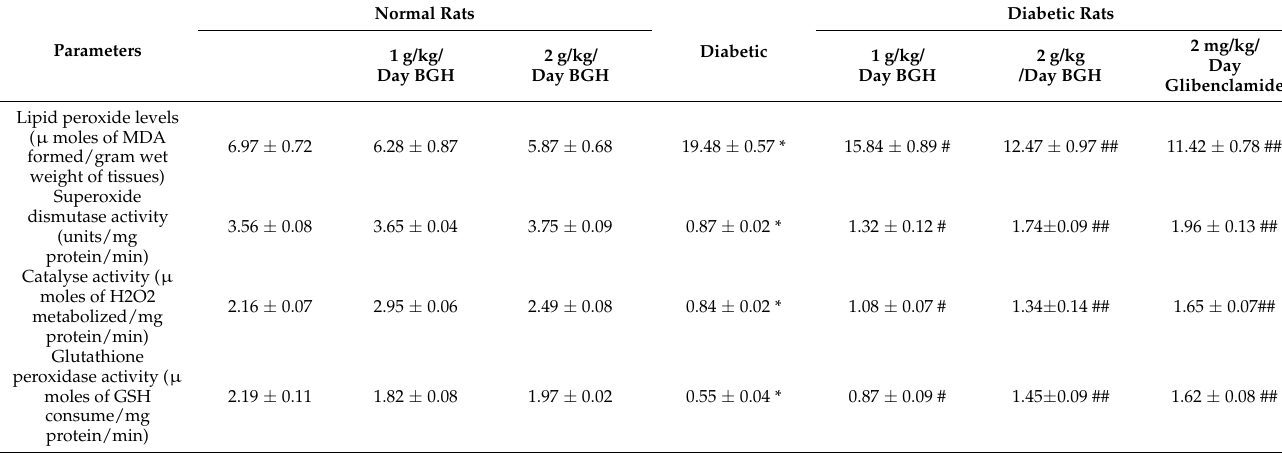
Table 4. Effect of BGH on lipid peroxidation levels, superoxide dismutase activity, catalyse activity, glutathione peroxidase activities in the kidney of streptozotocin–nicotinamide-induced diabetic rats. Normal Rats Diabetic Parameters Diabetic